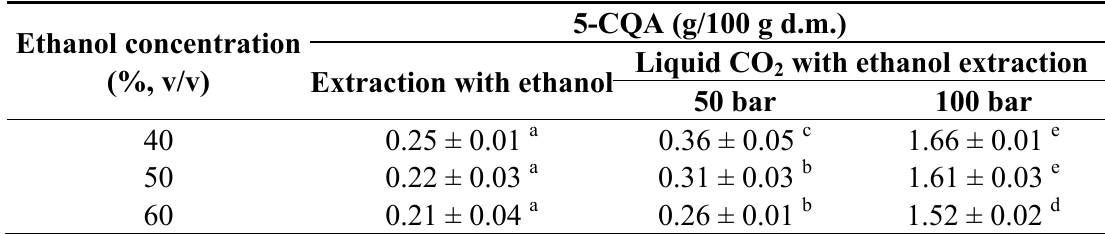
Table 2. 5-CQA content of mate ( Ilex paraguariensis ) leaves